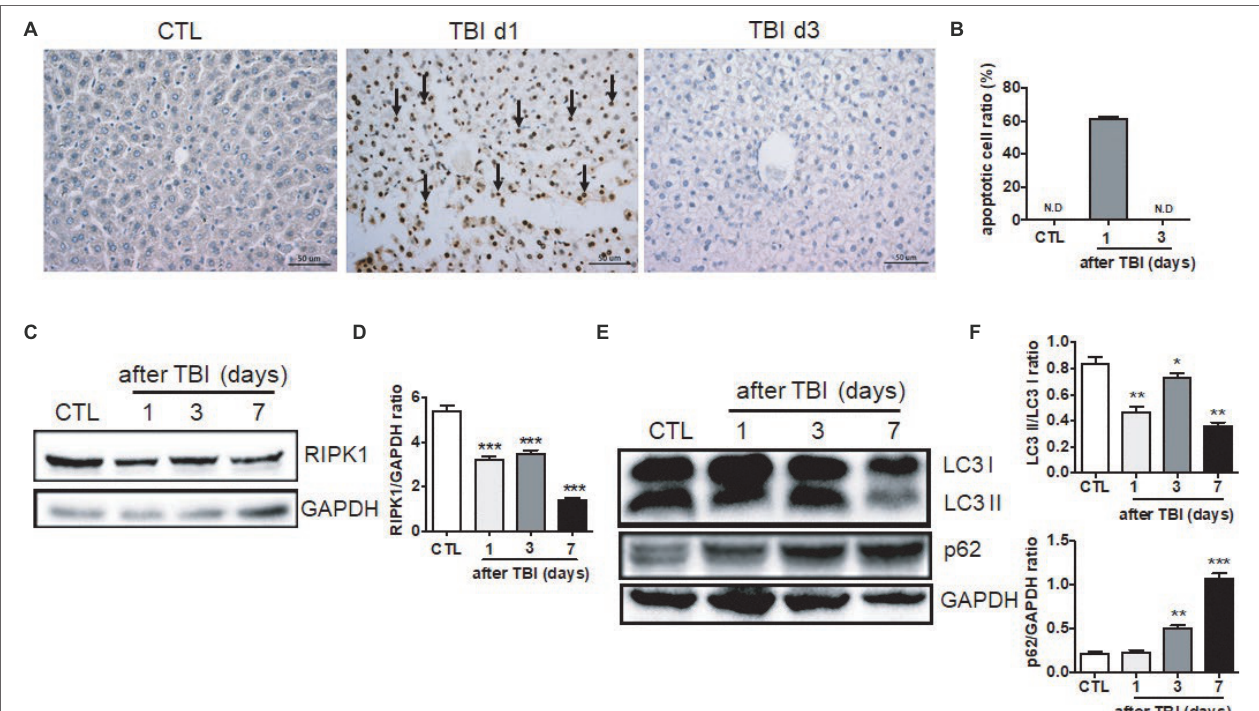
FIGURE 2 | Irradiation-induced cellular apoptosis in liver tissues. (A and B) Irradiated liver tissues were collected at days 1 and 3 after TBI. Representative pictures by TUNEL staining are shown (A , n = 6 ) . Scale bar = 50 μ m. Arrows indicate TUNEL-positive cells. The ratios of apoptotic cells in each field are presented in (B) (N.D: non-detected). (C and D) RIPK1 expression in liver tissues ( n = 3). Expression of RIPK1 in liver tissues was detected by western blotting (C) . GAPDH was used as a housekeeping control. Expression of RIPK1 was quantitated by ImageJ software (D) . (E and F) LC3 I, LC3II, and p62 expression in liver tissues ( n = 3). Expression of LC3 I, LC3II, and p62 (E) was detected by western blotting at days 1, 3, and 7 after irradiation. GAPDH was used as a housekeeping control. Expression of LC3 I, LC3II, and p62 (F) was quantitated by ImageJ software. The ratio of LC3 II/LC3 I was presented. * p < 0.05, ** p < 0.01, *** p < 0.001 vs.